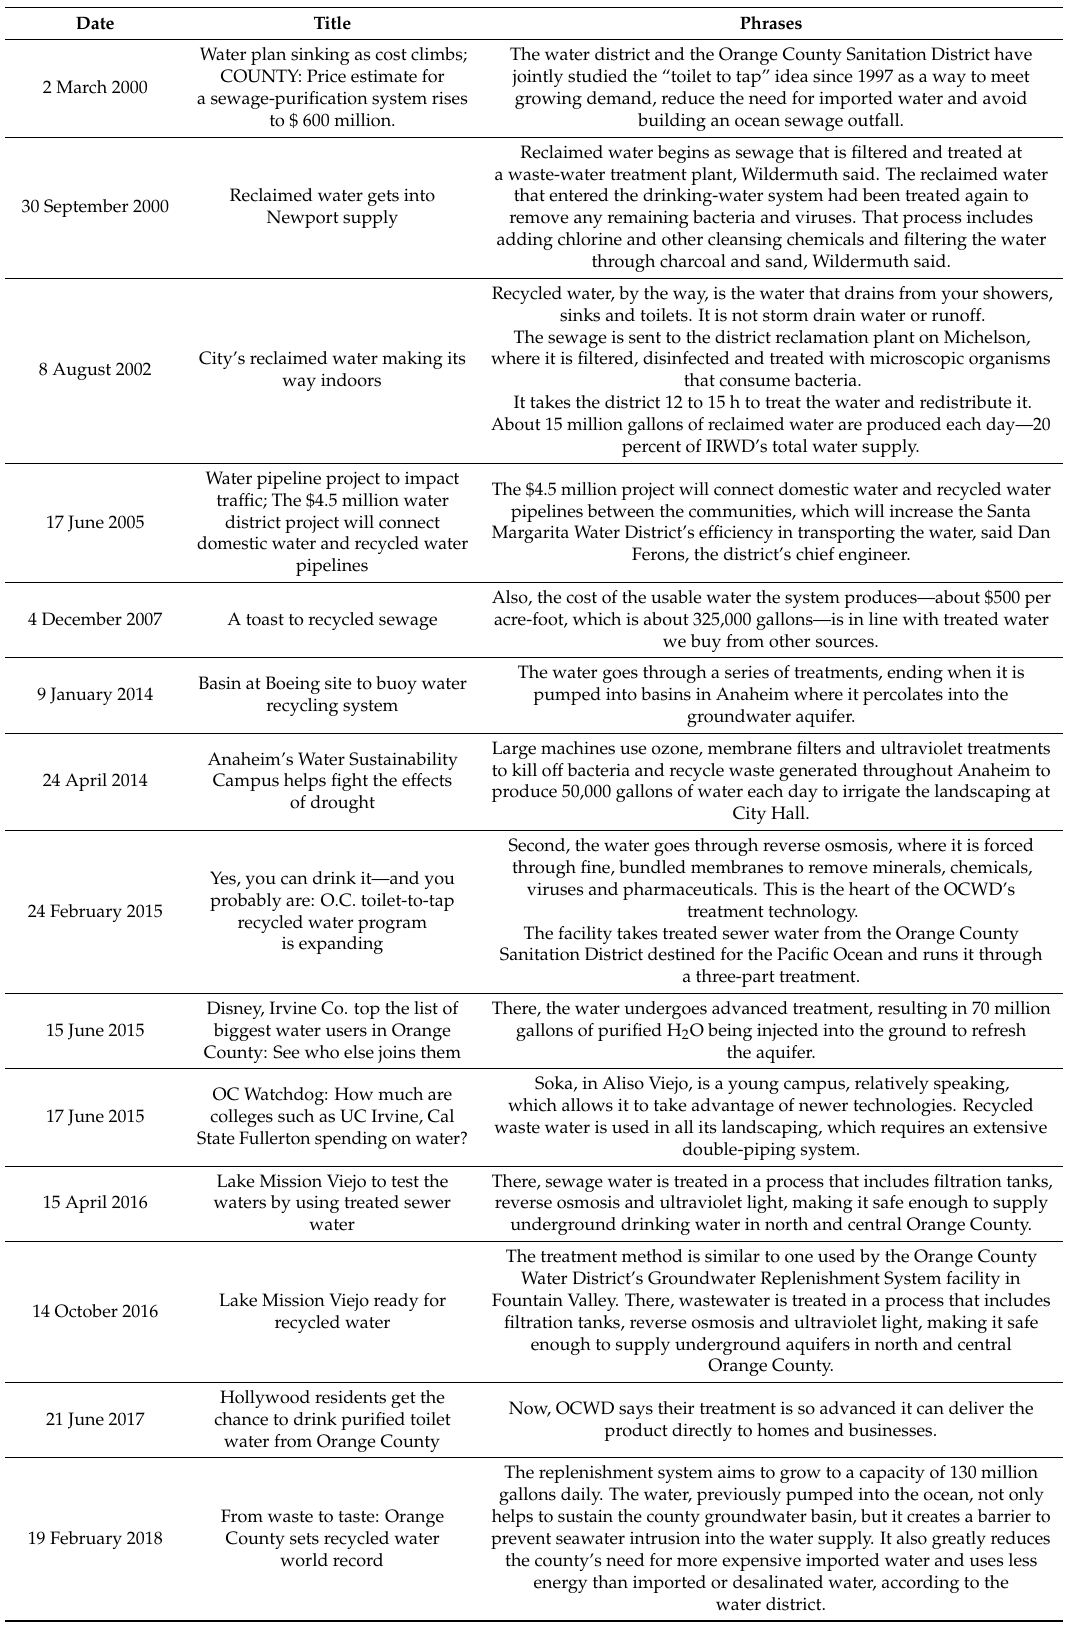
Table 3. Excerpts of selected newspaper articles in the Orange County